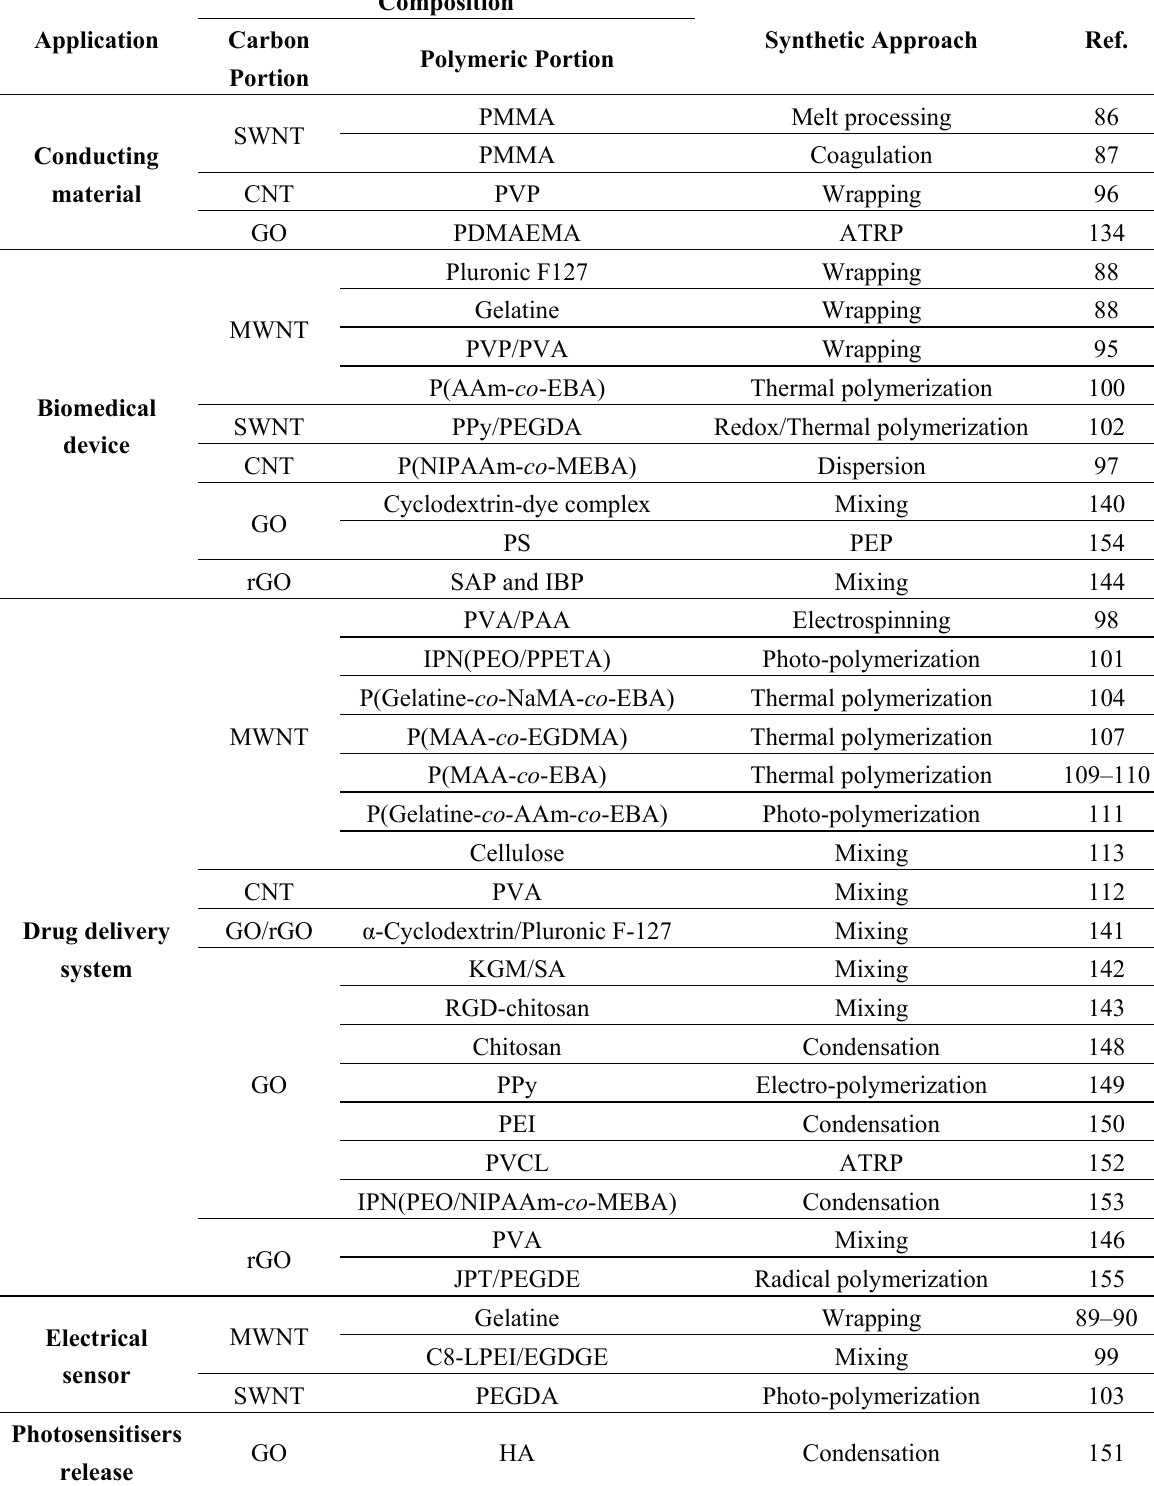
Table 1. Electro-responsive carbon nanohybrids discussed in this